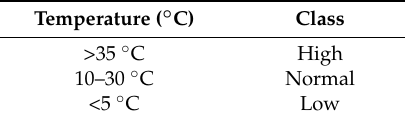
Table 5. Classes of humidity.